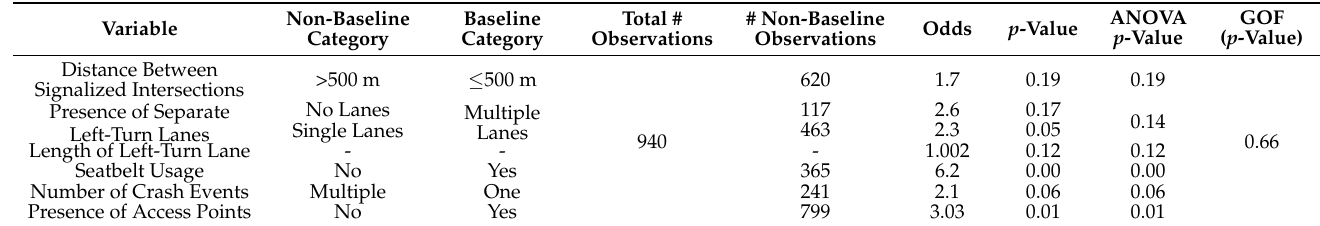
Table 5. Multivariate Signalized Intersection